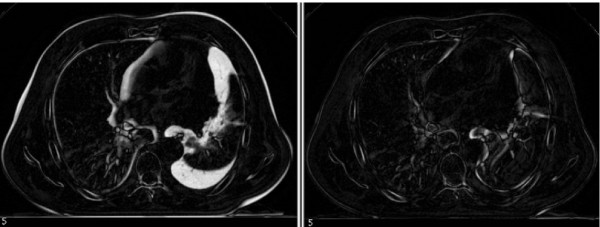
Image difference between kVCT and MVCT phase 3 in patient 4. Left: rigid registration, right: elastic registration. In this image pixel intensity is proportionally related to the degree of mismatching between images (black values matching, white values mismatching). White areas indicating mismatching between kVCT and registered MVCT image due to large pleural effusion in patient 4, were recovered by the elastic registration.